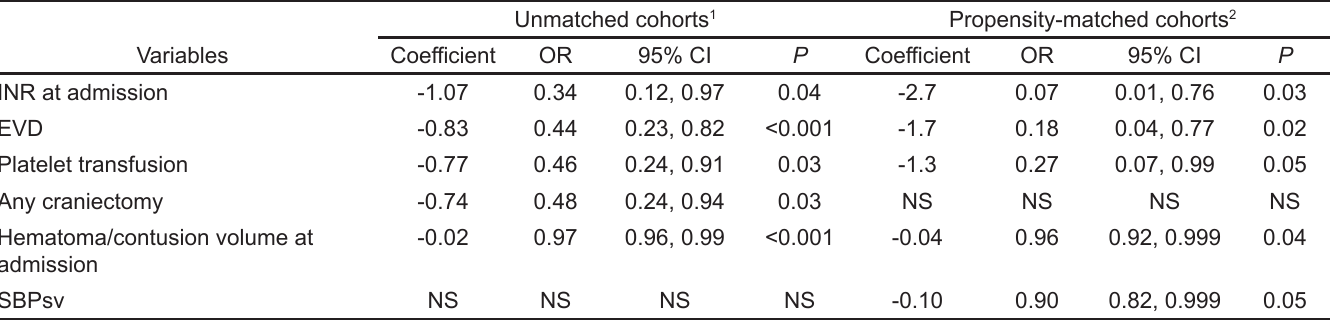
Table 5. Results of ordinal logistic regression to measure the association between patients’ characteristics, clinical course, and